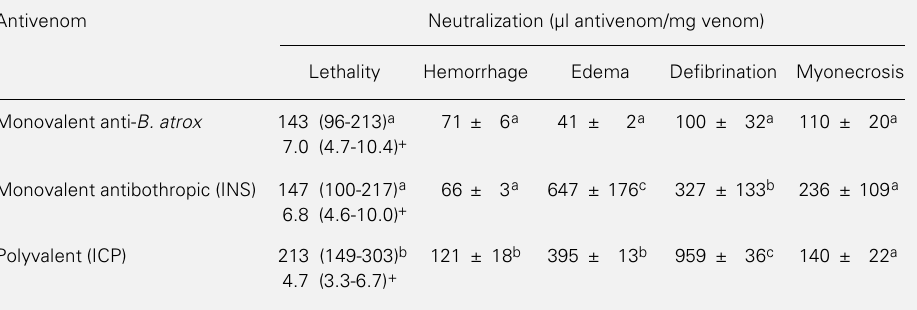
Table 2 - Neutralization of pharmacological activities of B. atrox venom from Antioquia and Choc(cid:243) by the three antivenoms. Neutralization is reported as effective dose 50% for lethal, hemorrhagic, edema-forming and myonecrotic effects and as effective dose 100% for the defibrinating effect (see Material and Methods). For lethality, results are reported as mean and 95% confidence limits (given in parentheses). For the other effects, results are reported as mean – SD (N = 3). Values with different superscripts (a,b,c) are significantly different (P<0.05) (Tukey test). + In the neutralization of lethality, results are also reported as mg venom neutralized per ml